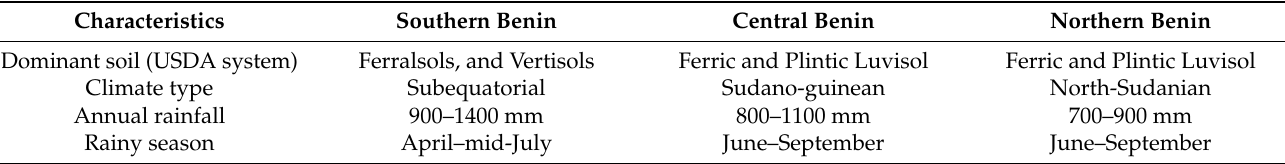
Table 1. Differences in soil and climate between agro-ecological zones [19–21].